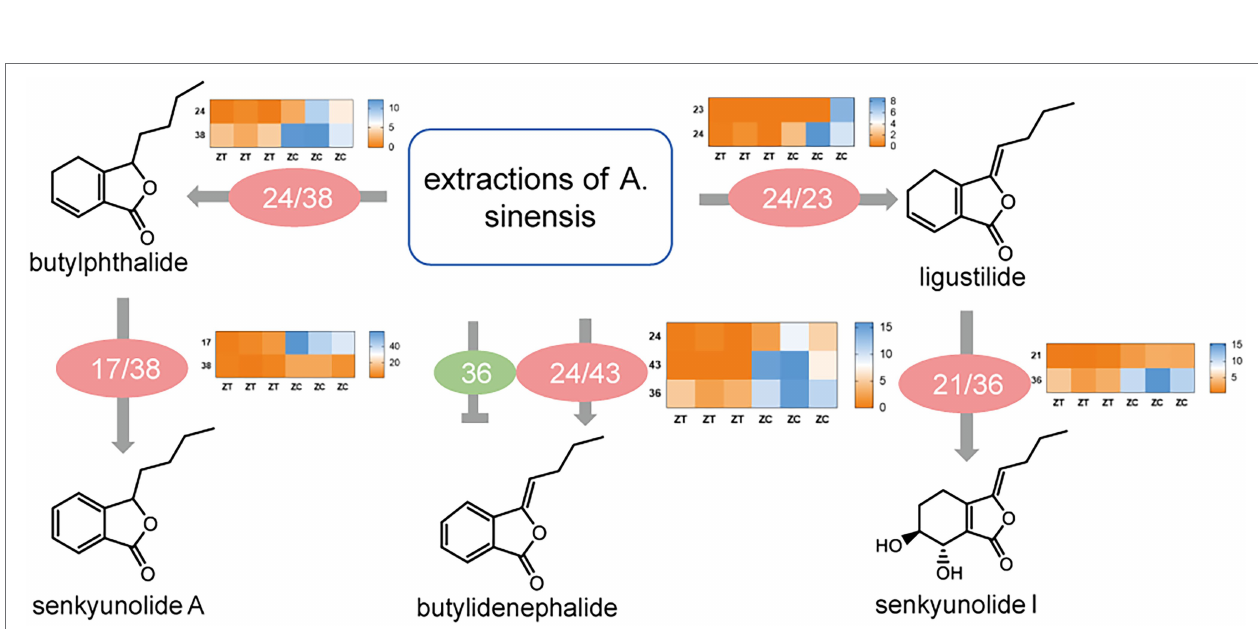
FIGURE 4 | The levels and relative expression of the tested components and isoforms across samples after treatment with methyl jasmonate.